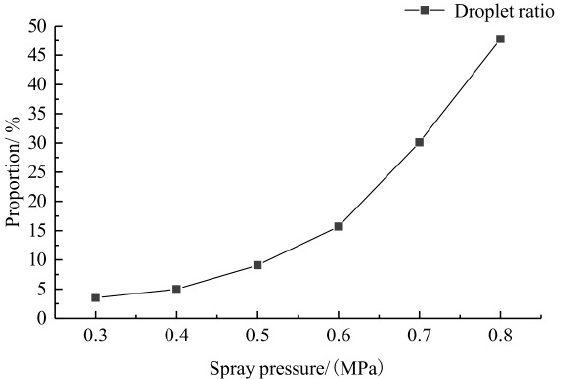
Figure 7. Proportion of drift droplets with different spray pressure.